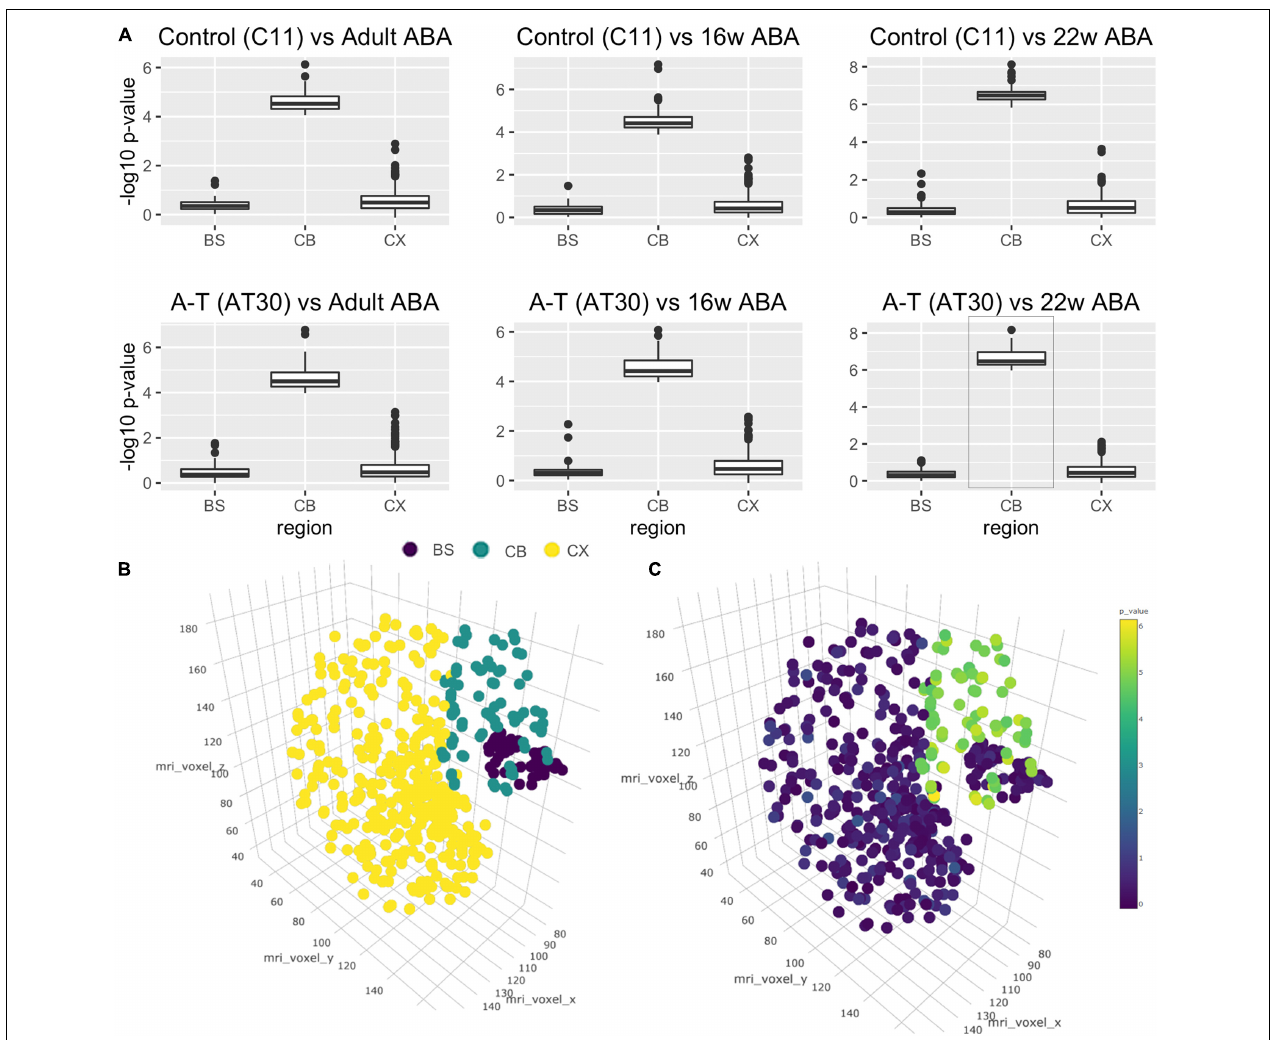
FIGURE 4 | Cross-study analysis using transcriptional data from the Allen Brain Atlas. (A) Wilcoxon’s rank-sum tests shows transcriptional similarity between brain regions and C11 (top)/AT30 (lower) cerebellar neurons. (B) Three-dimensional reconstruction of Allen Brain Atlas data demonstrating discrete regions (BS, brain stem; purple/CB, cerebellum; teal/CX, cortex; yellow). (C) Three-dimensional reconstruction of Allen Brain Atlas samples showing − log10 p -values pertaining to comparison of differentiated cells to Allen Brain Atlas data from that